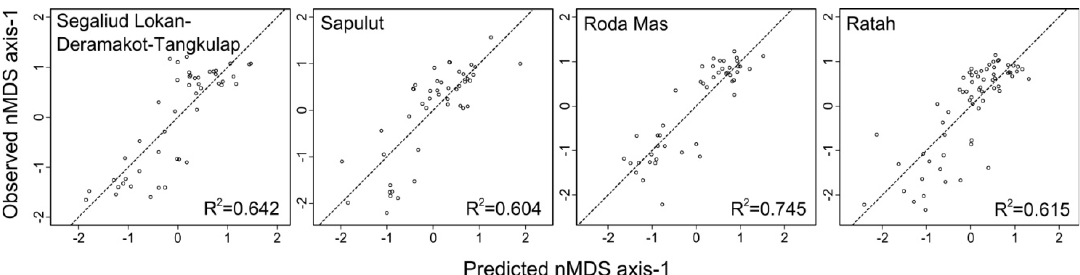
Figure 2. Model fits for all available inventory plots in each FMU. Scatter plots show relationships between predicted and observed scores.